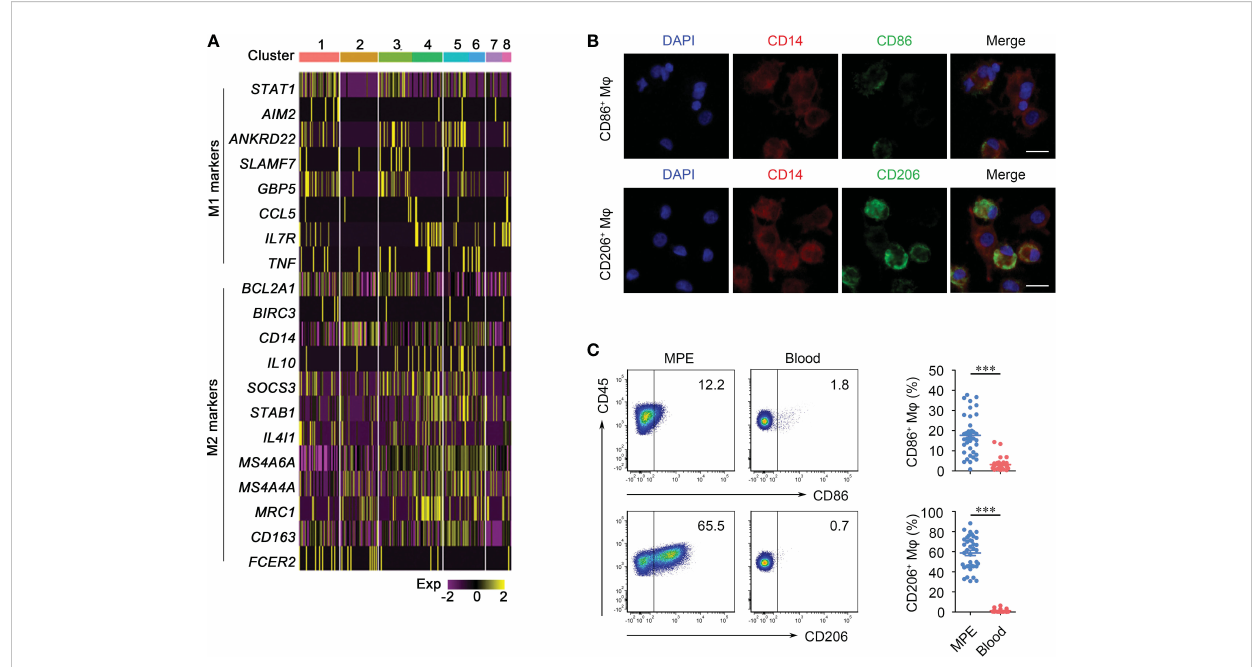
FIGURE 1 Phenotypes of macrophages (M j s) in malignant pleural effusion (MPE). (A) Heatmap shows the marker genes of M1 and M2 pattern of M j s in sub- clusters. (B) Immuno fl uorescence images of CD86 + M j (upper panel) and CD206 + M j (bottom panel). Representative images are shown; 200 × magni fi cation; scale bar, 20 m m. Red, CD14; green, CD86/CD206; blue, DAPI. (C) Representative fl ow cytometry plots of CD86 + M j and CD206 + M j (gated on CD45 + CD14 + M j ) in MPE and the corresponding blood (left panel). Comparisons of percentages of CD86 + M j and CD206 + M j are shown in MPE and blood (right panel) (n = 38). Comparisons were made using Student ’ s t test; *** P <